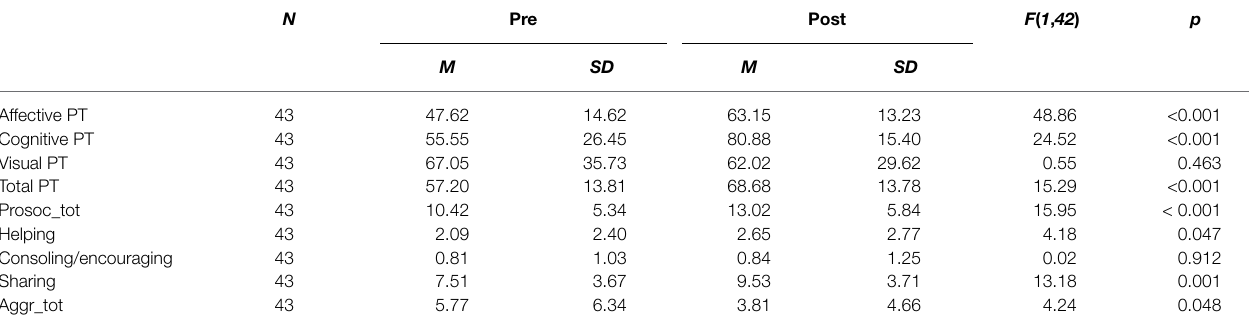
TABLE 7 | Descriptive statistics and values of the pre-test/post-test variables. N Pre Post F ( 1 , 42 ) p M SD M